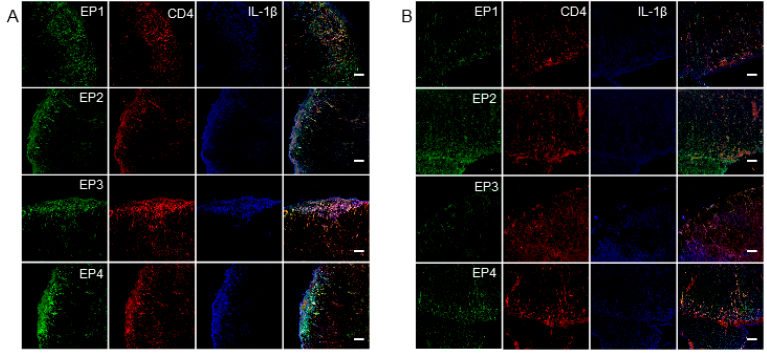
Figure 3. Expression of EP receptors and interleukin-1 β (IL-1 β ) in CD4 + T cells in EAE spinal cords. Immunohistochemistry image showing EP1–4 (green), CD4 (red), and IL-1 β (blue) in the inflammatory region of the spinal cords of EAE wild-type mice ( A ) and EAE mPGES-1 − / − mice ( B ). Scale bar (50 μ m) for all images.